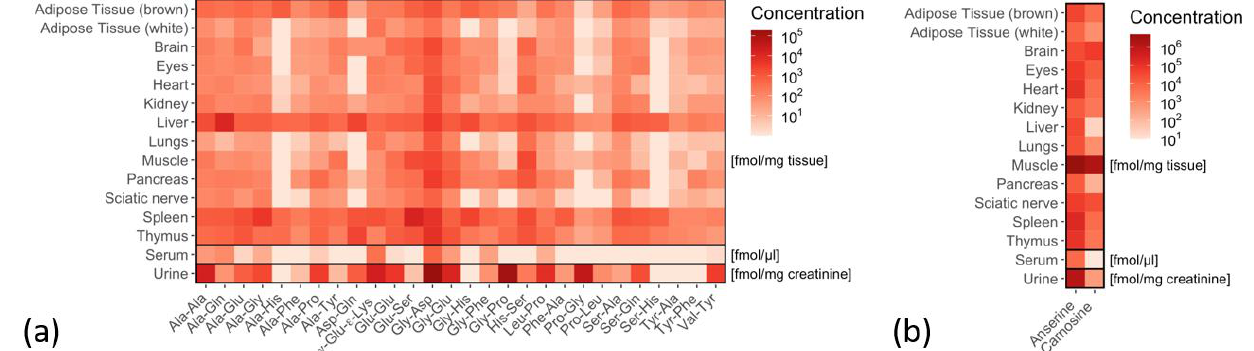
Int. J. Mol. Sci. 2021 , 22 , x FOR PEER REVIEW Figure 2. Distribution of dipeptides in murine tissues and biofluids. ( a ) Heat map showing the concentrations for 28 dipeptides and ( b ) carnosine and anserine in murine tissues ( n = 6, except for urine n = 5). Mean values are given in fmol/mg tissue. In serum, the concentrations are given in fmol/ µ L and in urine in fmol/mg creatinine.